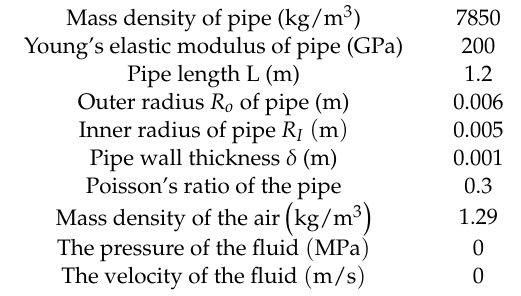
Table 3. The physical parameters of the pipeline and the fluid for simulation.